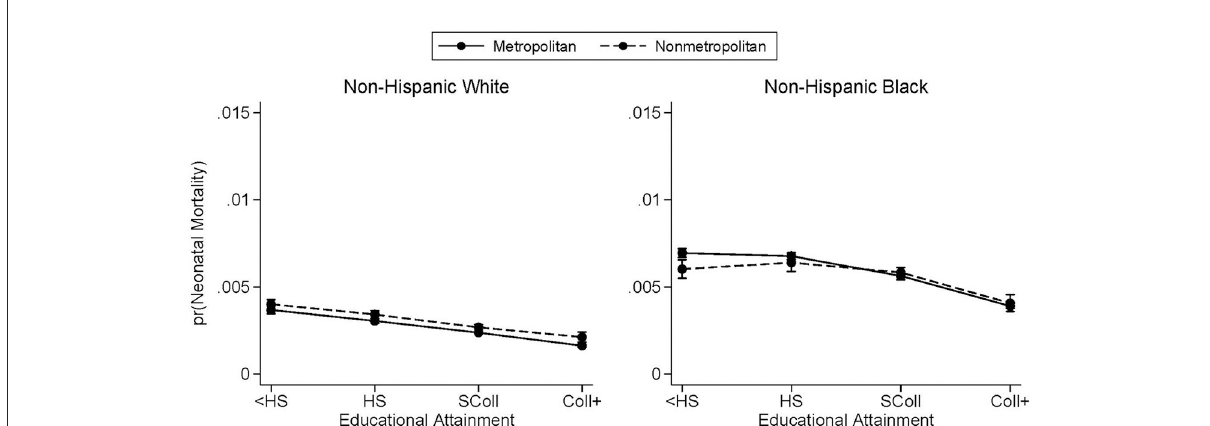
FIGURE3 Predicted probabilities of neonatal mortality by metropolitan residence and race. Neonatal mortality is infant death occurring between days 0 and 27. Predicted probabilities are from logistic regressions controlling for mother’s age, mother’s marital status, first trimester prenatal care, child’s sex, birth order, birth year, U.S. region of birth, and mother’s county of residence’s metropolitan status. See Supplementary Table 2 for full regression results. Births occurred between the years 2011 and 2015. Educational attainment is observed only from the revised birth certificates which had not yet been adopted by every state.